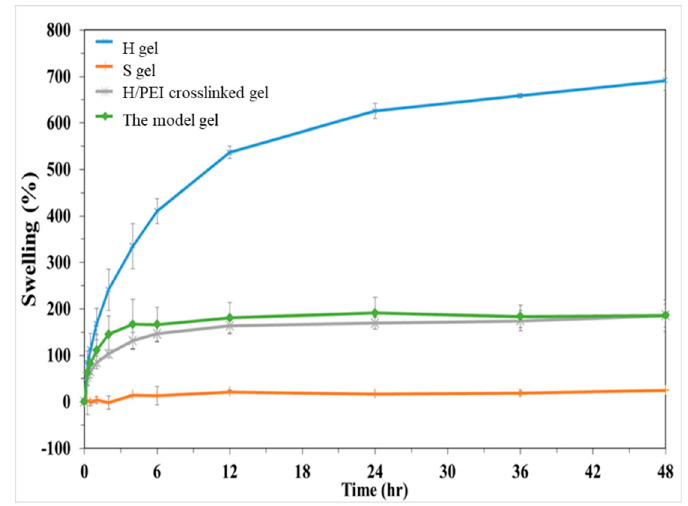
Figure 3. The swelling ratios for H, S, H/PEI crosslinked and the model hydrogels in PBS were shown. The swelling ratios for the H gels were significantly higher than others ( p < 0.01, n = 3), while those for S gels were significantly lower than others ( p < 0.01, n = 3). The swelling ratios of the model hydrogels in PBS were similar to those for crosslinking H/PEI crosslinked hydrogels between those of H and S hydrogels (Data are mean ± SD, n = 3).